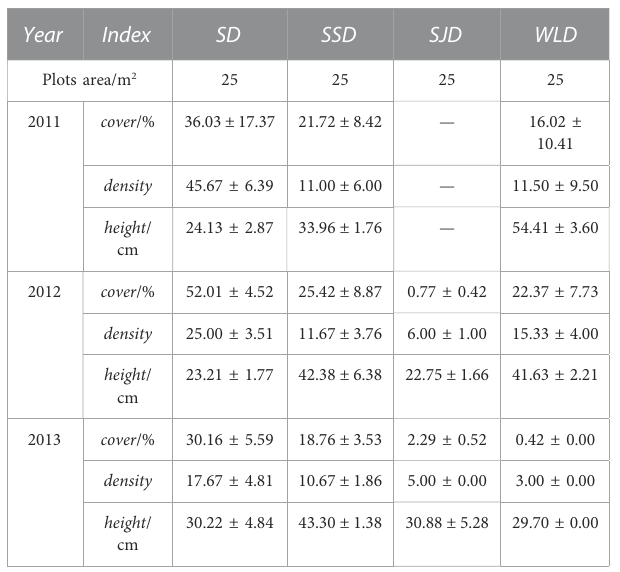
TABLE 5 Features of Artemisia ordosica in different dunes